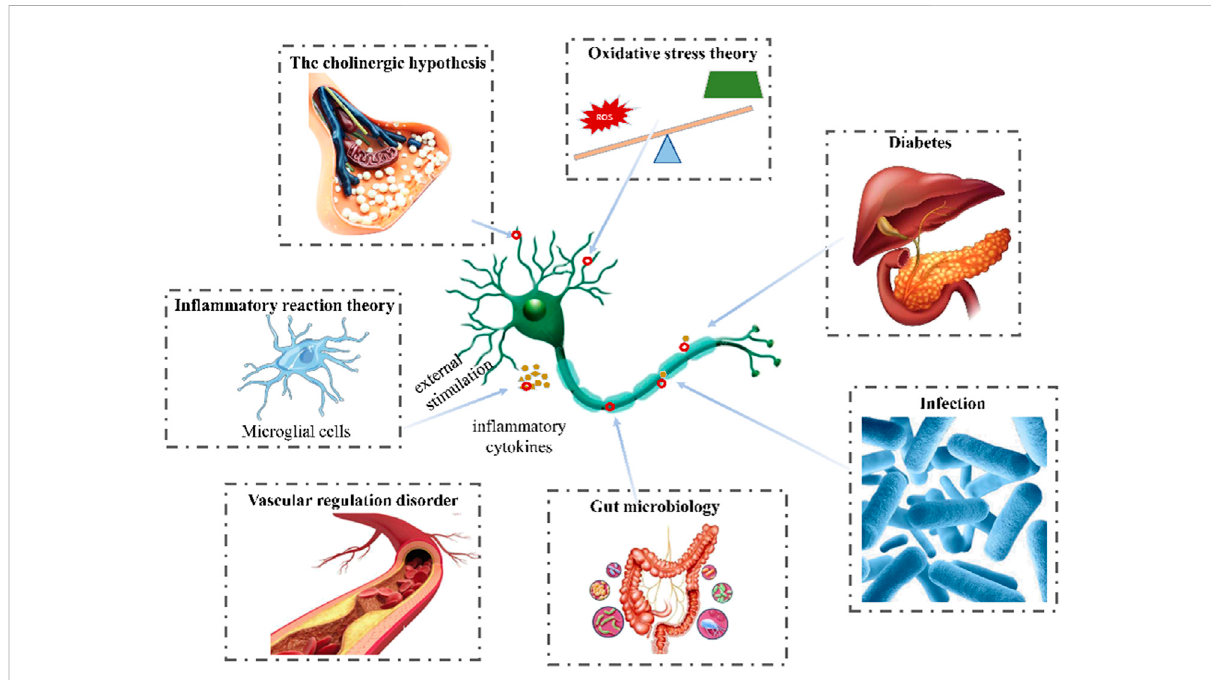
FIGURE 1 Pathogenesis of AD (The pathogenesis of AD include vascular regulation disorder, infection, diabetes, in fl ammatory, oxidative stress, the cholinergic hypothesis, glutamic acid pathway and gut